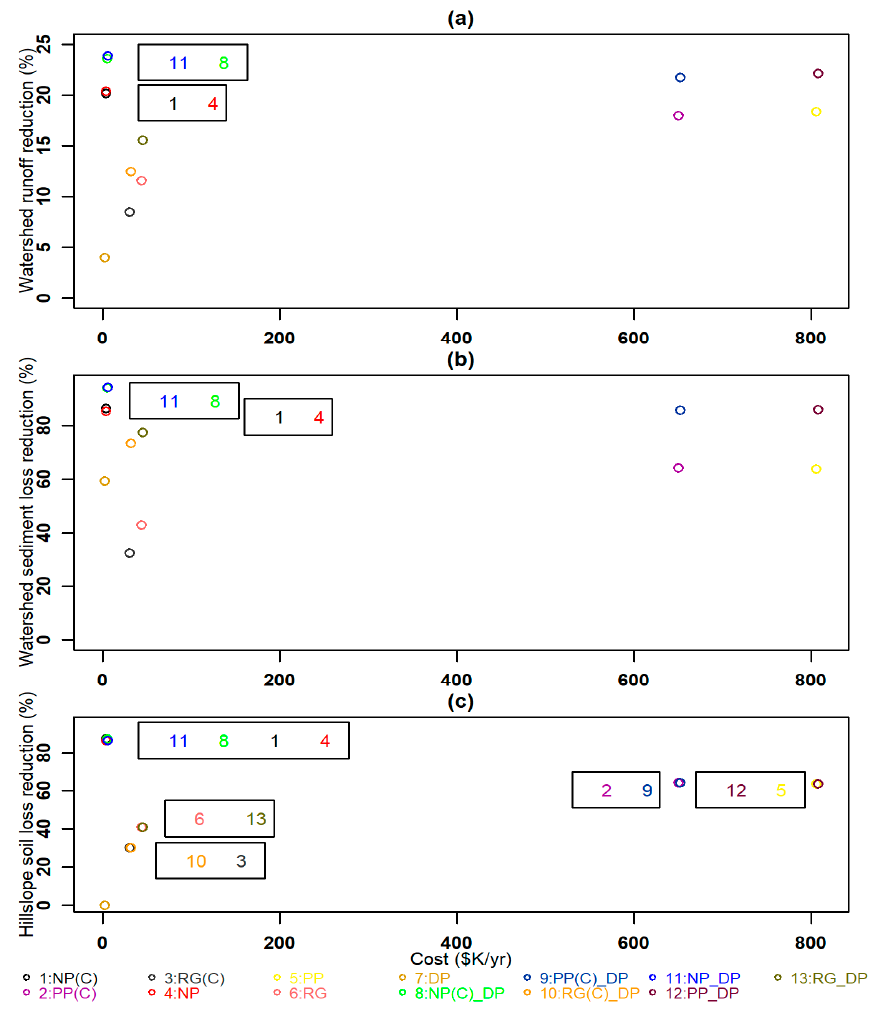
Figure 4. The costs and the impacts of the Low Impact Development scenarios on average annual percentage reductions in runoff volumes at the watershed outlet ( a ), sediment losses at the watershed outlet ( b ), and soil losses from the hillslopes ( c ). The scenario numbers of overlapped circles are shown in the adjacent text boxes.